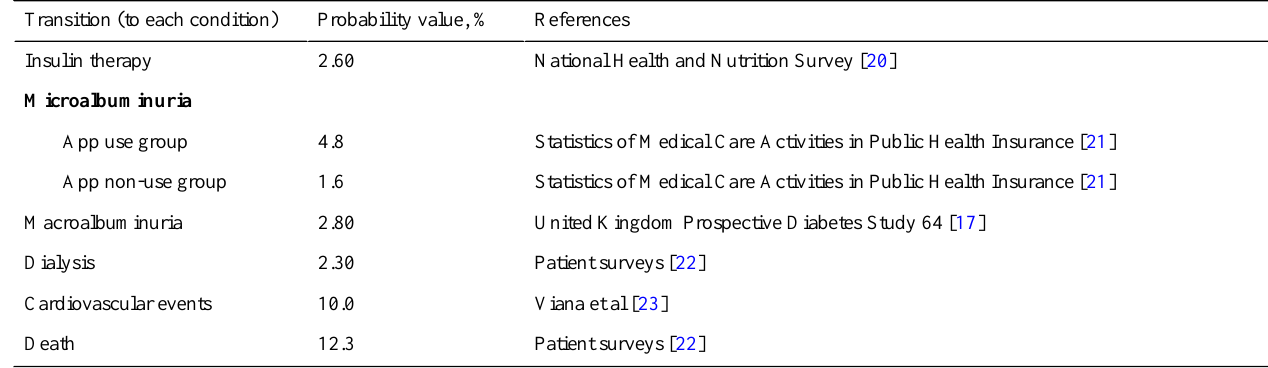
Table 1. Probability value of each patient condition.